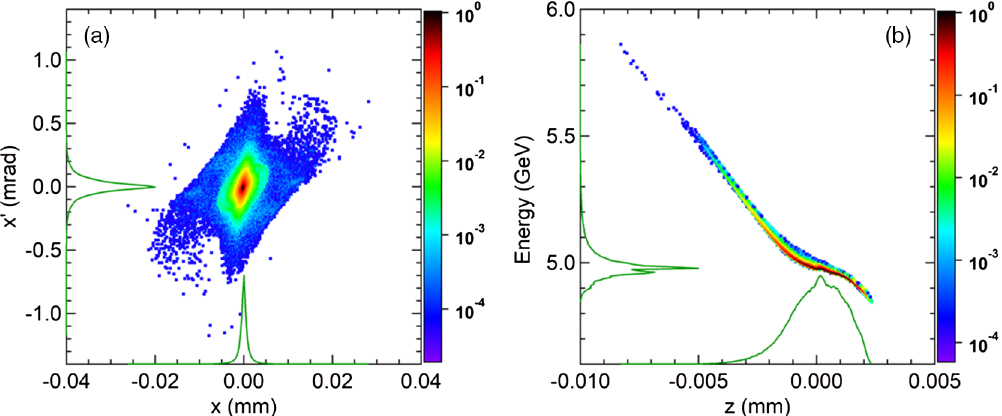
FIG. 4. Beam density distribution at the exit of the scheme-2 LPAS (see the text), for 500000 macroparticles. (a) Projection onto the phase space (x, x 0 ), i.e., transverse position and angle. (b) Projection onto (z, E), i.e., longitudinal position and energy. The color bar on the right represents the density scale normalized to 1. The green lines on the axes are the projections onto the axes x, x 0 , z, and